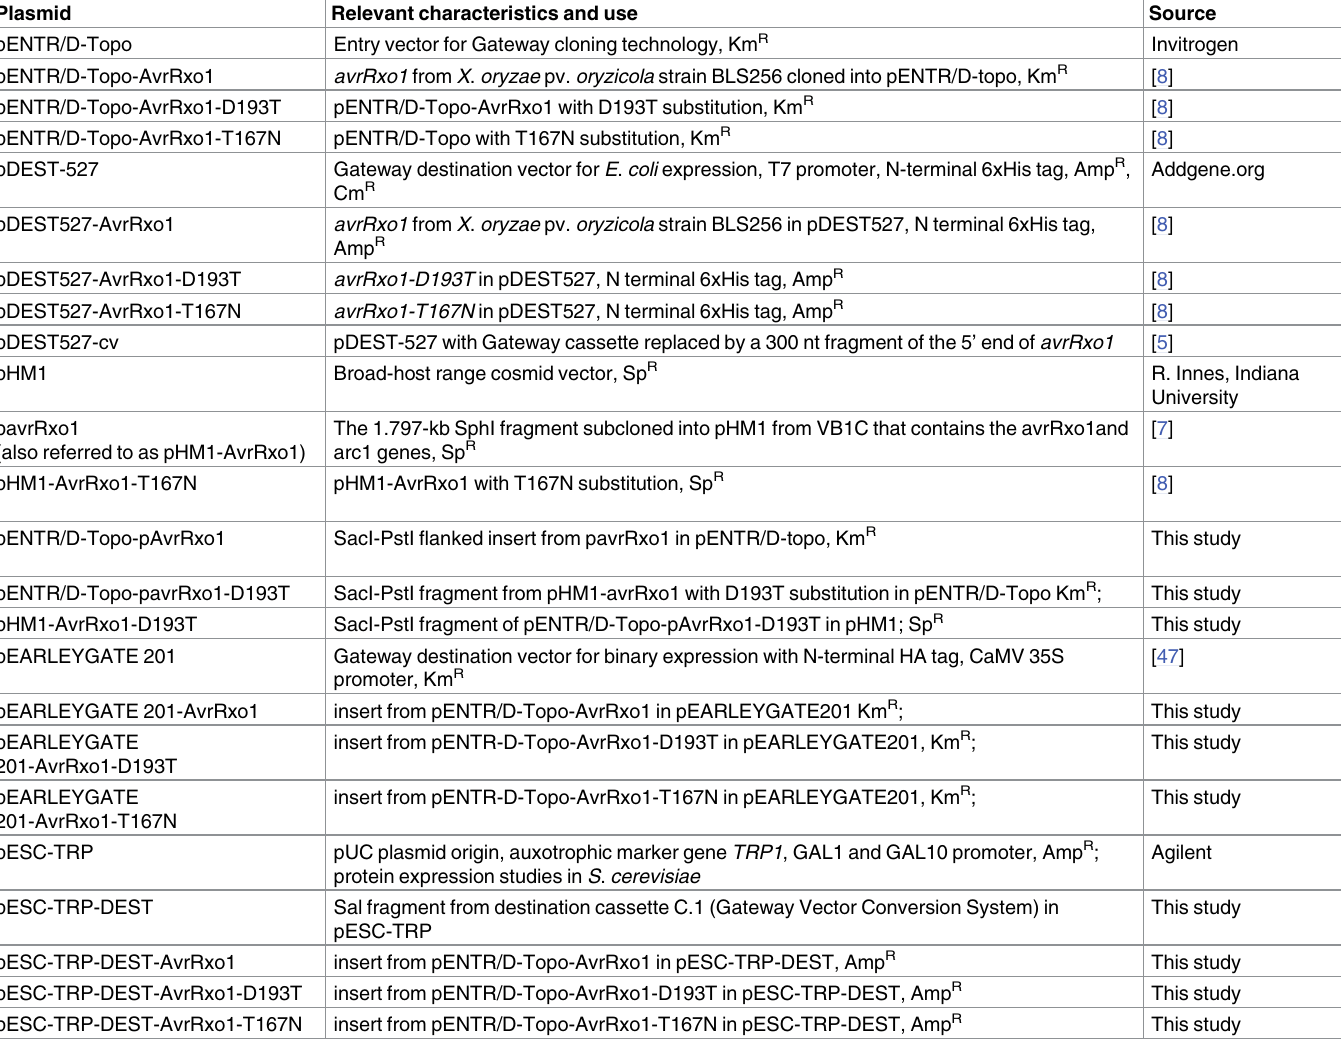
Table 2. List of plasmids used in this